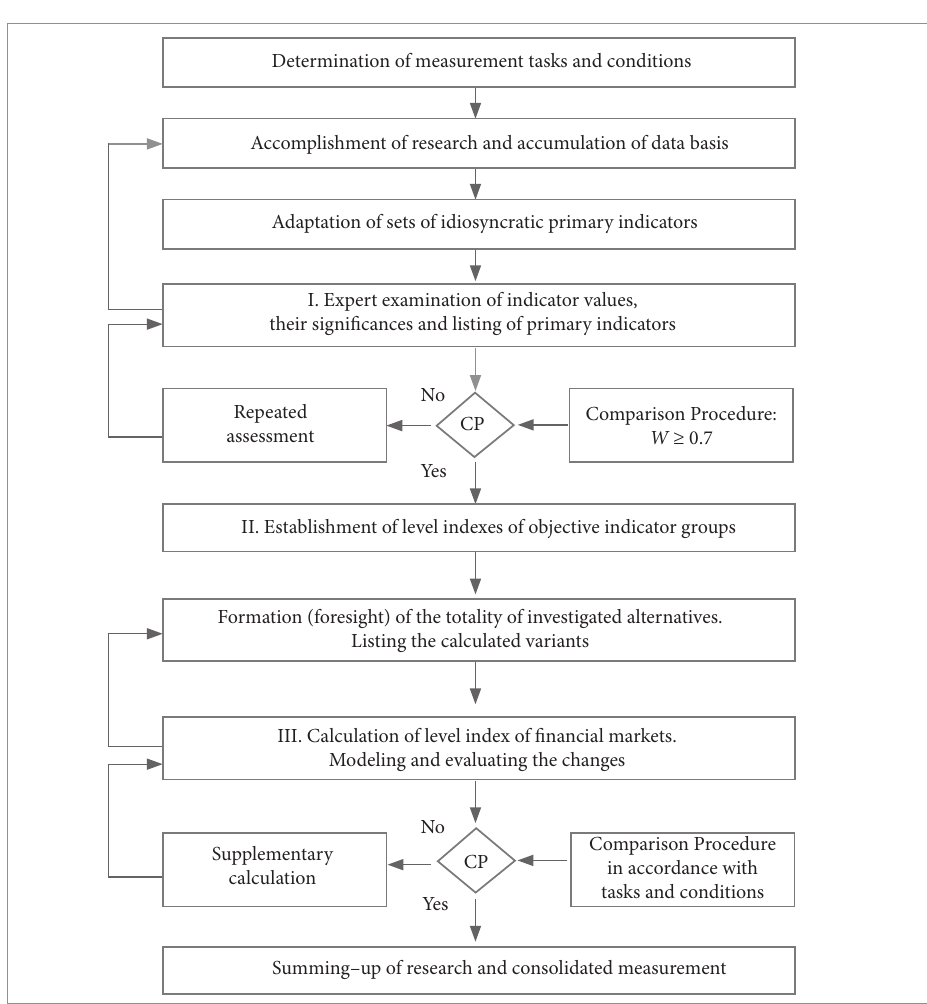
Fig. 1. Principal scheme of the measurement of financial market development at national level